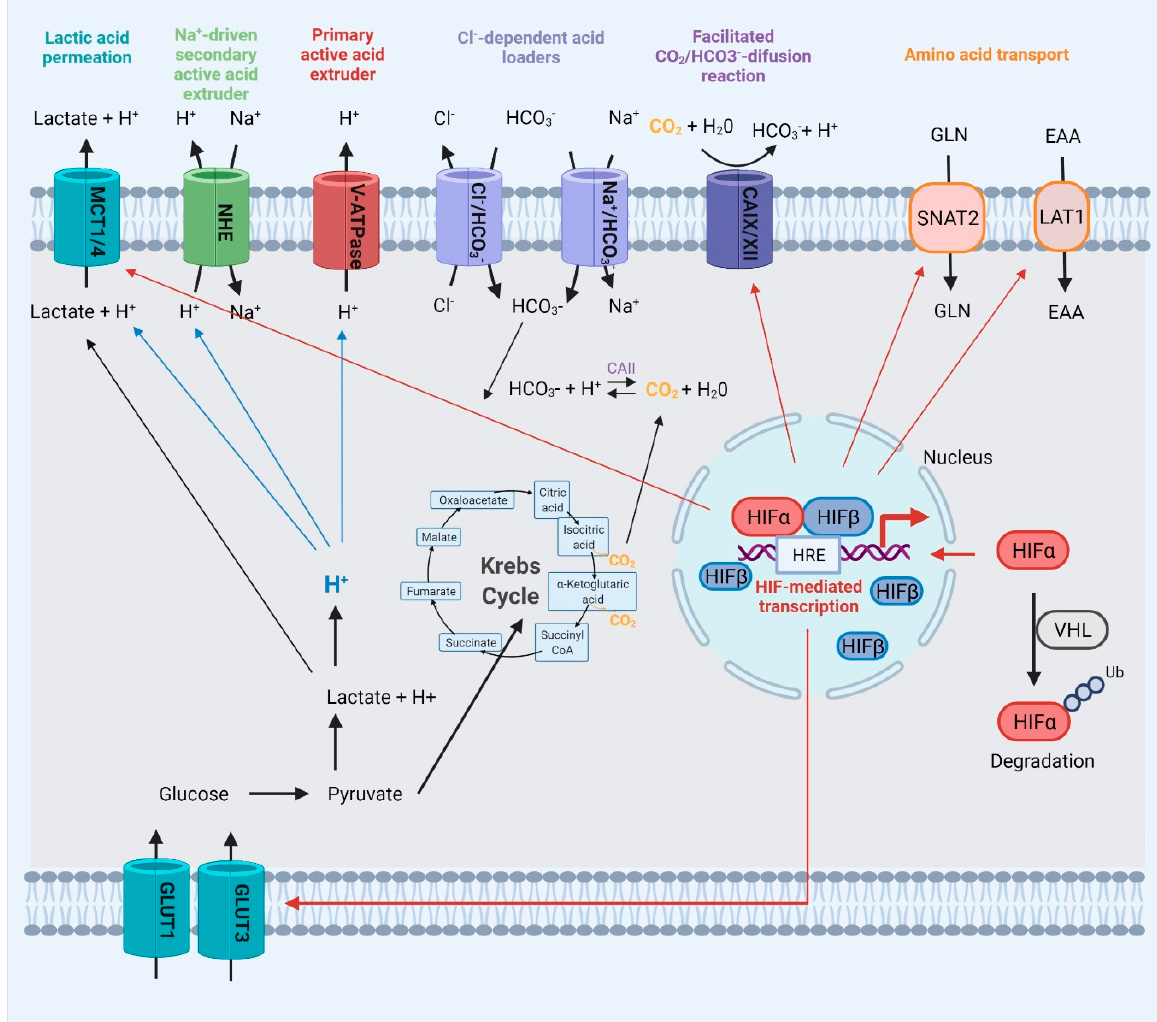
Figure 2. Major metabolic adaptations of cancer cells during metastasis with special focus on ways by which cancer cells avoid repercussions resulting from hypoxia and lack of nutrients. Hypoxia- inducible transcription factor α (HIF1 α ) is a transcription factor for many genes involved in anaerobic metabolisms, angiogenesis, and metastasis. HIF α subunit is targeted for degradation by the von Hippel–Lindau tumor suppressor (VHL) under normoxic conditions; however, the occurrence of hypoxia allows the translocation of the HIF α subunit to the nucleus and formation of transcription factor complexes with constitutively expressed HIF β subunit. The transcription factor regulates the expression of various genes containing HIF-responsive elements (HRE) such as carbonic an- hydrases, glucose transporters, and vascular endothelial growth factor (VEGF). MCT1–MCT4 are proton-coupled monocarboxylate (lactate, pyruvate, and ketone) transporters. Sodium hydrogen ion exchangers (NHE) regulate the intracellular pH regulation via electroneutral, 1:1, exchange of Na + and H + along their gradients. Vacuolar-type H + adenosine triphosphatases (V-ATPases) transport H + across membranes in an active process. Carbonic anhydrases (CA) are zinc metalloproteins that catalyze the reversible hydration of CO 2 to form HCO 3 − and H + . CO 2 is also the main byprod- uct of the Krebs cycle and may be generated from HCO 3 − in reactions catalyzed by CAII. HIF transcription factor governs the expression of MCT1/4, glucose transporters (GLUT1/3), amino acid transporters—sodium-coupled neutral amino acid transporter 2 (SNAT2), large neutral amino acid transporter 1 (LAT1), and CAIX/CAXII. Cl − /HCO 3 − —chloride bicarbonate anion exchangers; Na + /HCO 3 − —sodium-dependent bicarbonate